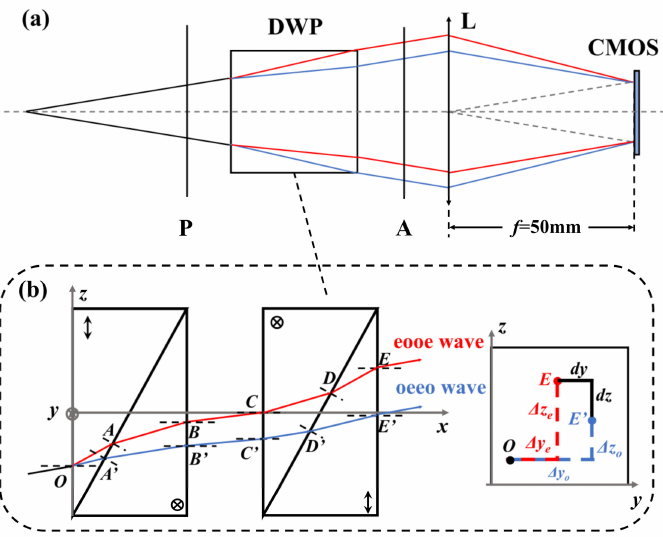
Figure 3. ( a ) Waves’ propagation and displacement in SBFTIS ( b ) Waves’ propagation and displace- ment in DWP (For calcite WP, projected on the OXZ